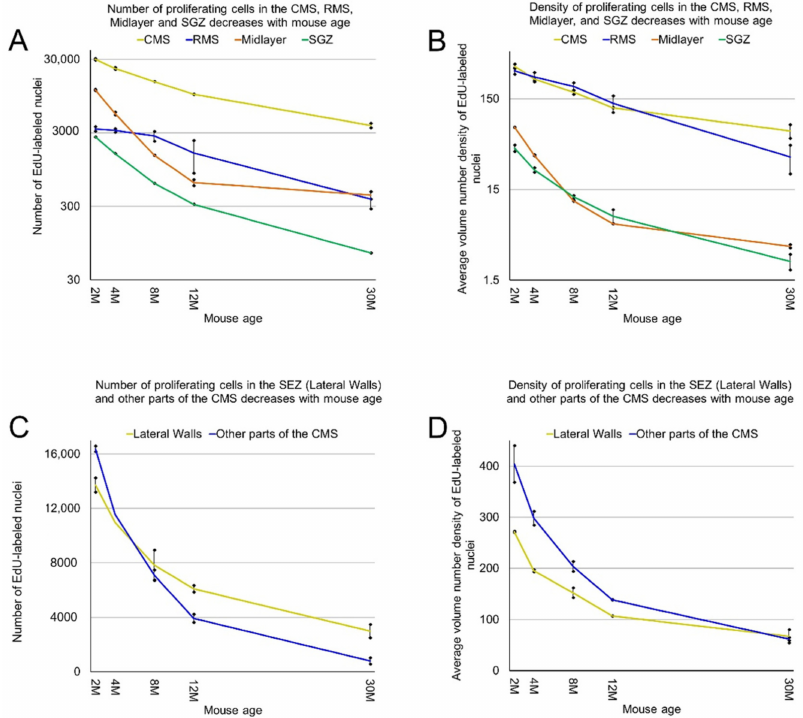
Figure 9. Age-related decrease in the number and density of proliferating cells in the CMS, RMS, midlayer, and SGZ. ( A ) The number of detected proliferating cells in the CMS, RMS, midlayer, and SGZ decreases with mouse age. The means of the number of proliferating cells in the CMS are significantly heterogeneous (one-way ANOVA, F4, 5 = 950, p = 2.2 × 10 − 7 ). The means of the number of proliferating cells in the RMS are significantly heterogeneous (one-way ANOVA, F4, 5 = 19, p = 3.1 × 10 − 3 ). The means of the number of proliferating cells in the midlayer are significantly heterogeneous (one-way ANOVA, F4, 5 = 1783, p = 4.5 × 10 − 8 ). The means of the number of proliferating cells in the SGZ are significantly heterogeneous (one-way ANOVA, F4, 5 = 828, p = 3.1 × 10 − 7 ); ( B ) the average volume number density of detected proliferating cells in the CMS, RMS, midlayer, and SGZ decreases with mouse age; ( C ) The number of detected proliferating cells in the subependymal zone (SEZ) and other parts of the CMS decreases with mouse age; ( D ) the average volume number density of detected proliferating cells in the SEZ and other parts of the CMS decreases with mouse age. Table 2. Estimated numbers of new cells produced in the mouse brain and its compartments between ages 2 and 30 months. Mouse Brain MPZ